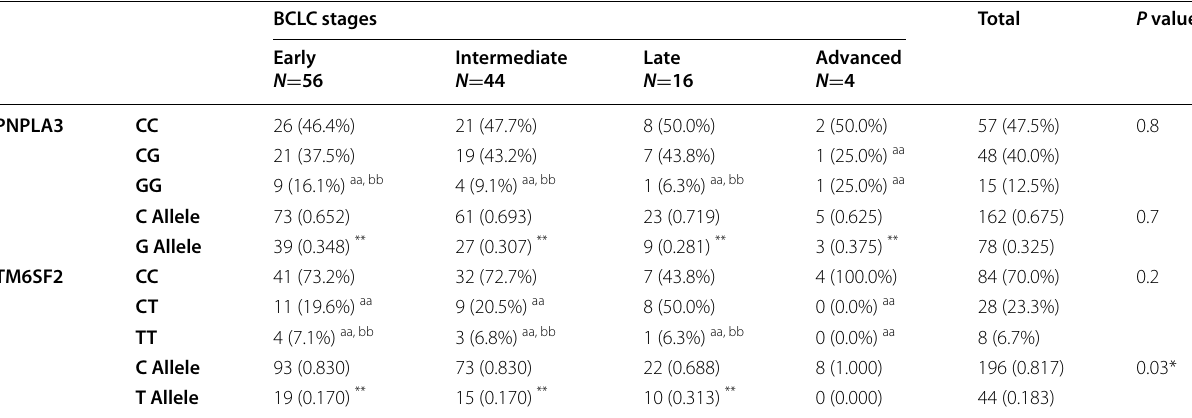
Table 4 Association of BCLC staging with genotype distribution of the studied genes